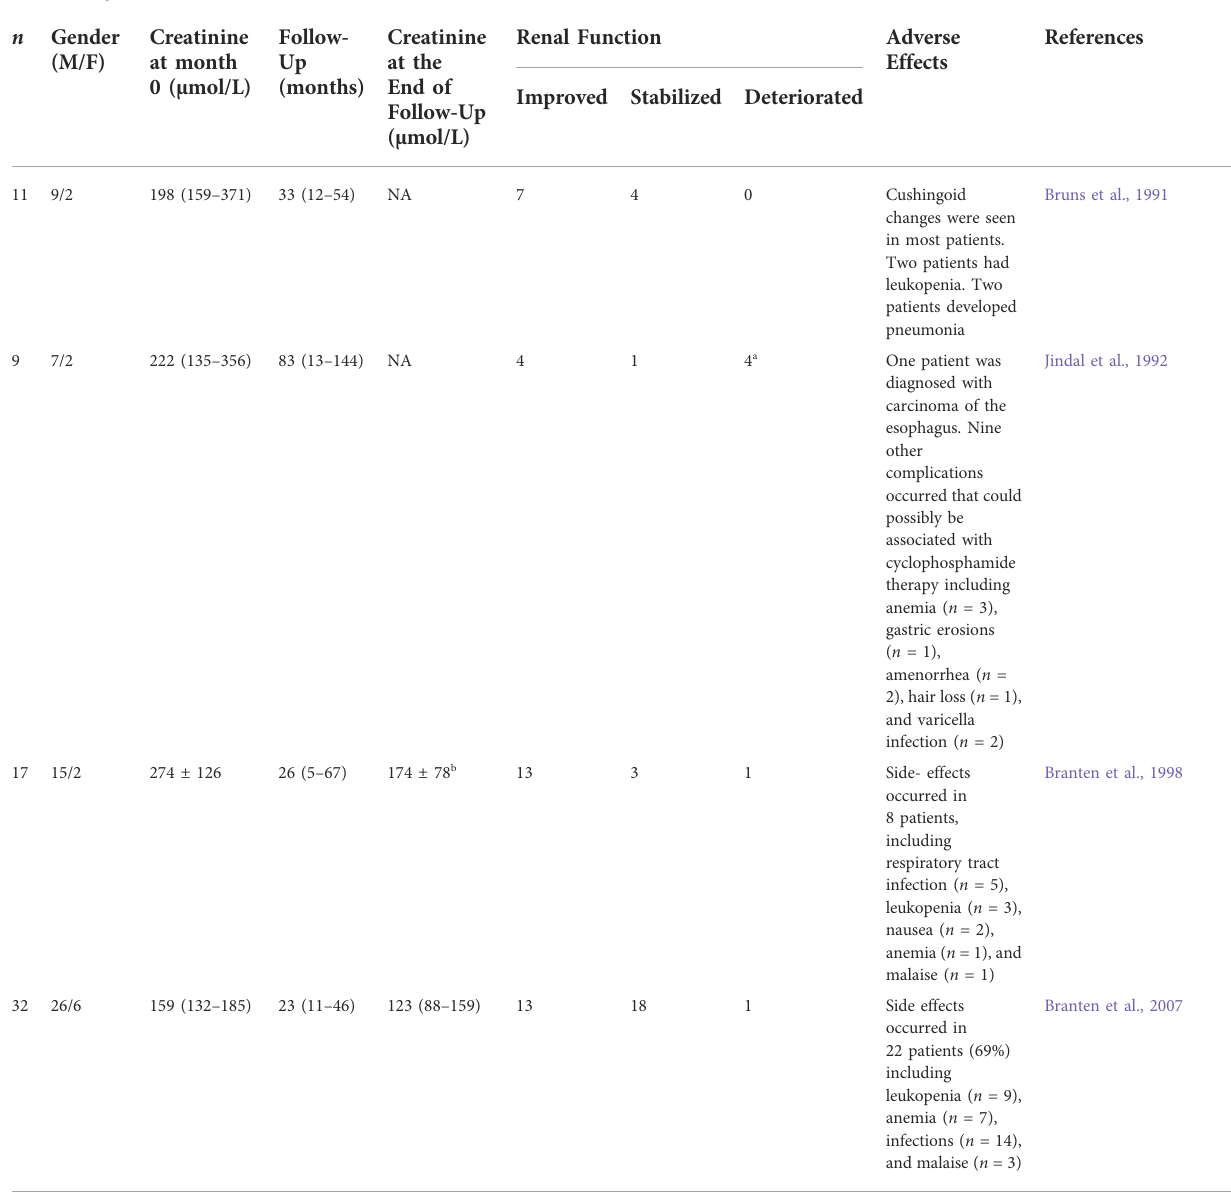
TABLE 5 Summary of therapeutic trials about the effectiveness and safety of cyclophosphamide in membranous nephropathy with kidney insuf fi ciency. n Gender